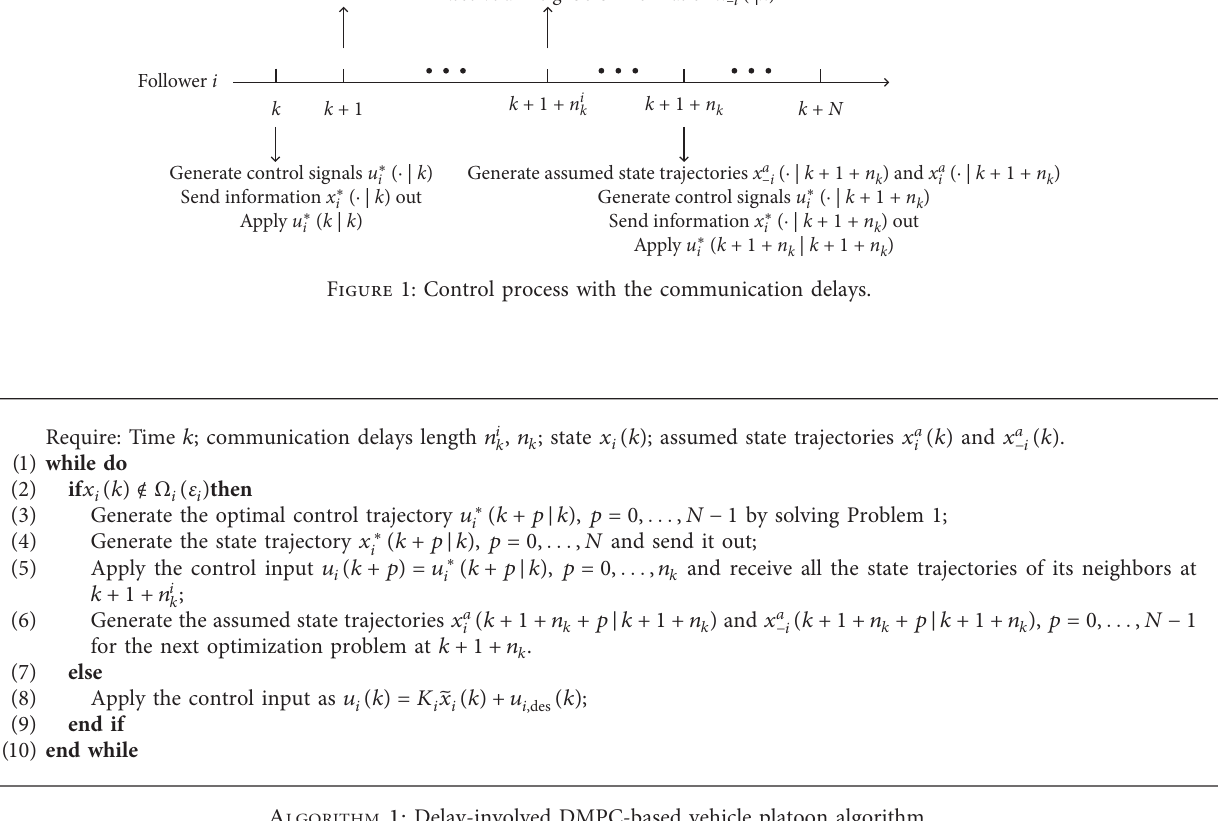
A LGORITHM 1: Delay-involved DMPC-based vehicle platoon